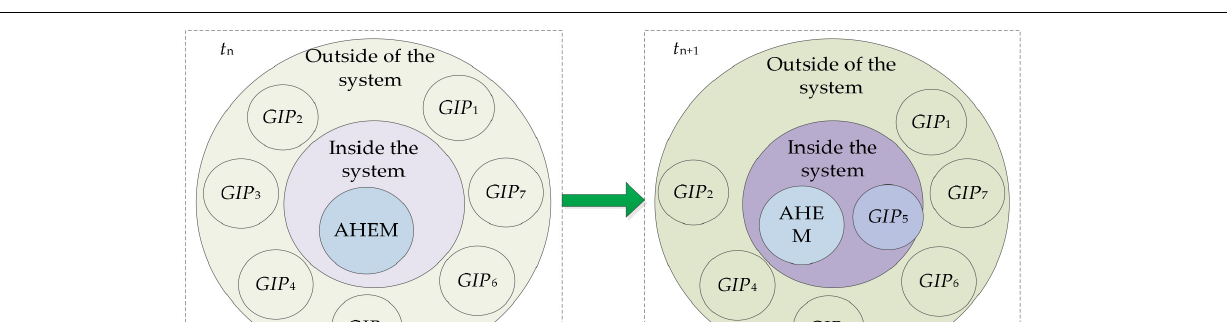
FIGURE 4 | The hierarchical structure of AHEM enterprises and academic institutions.